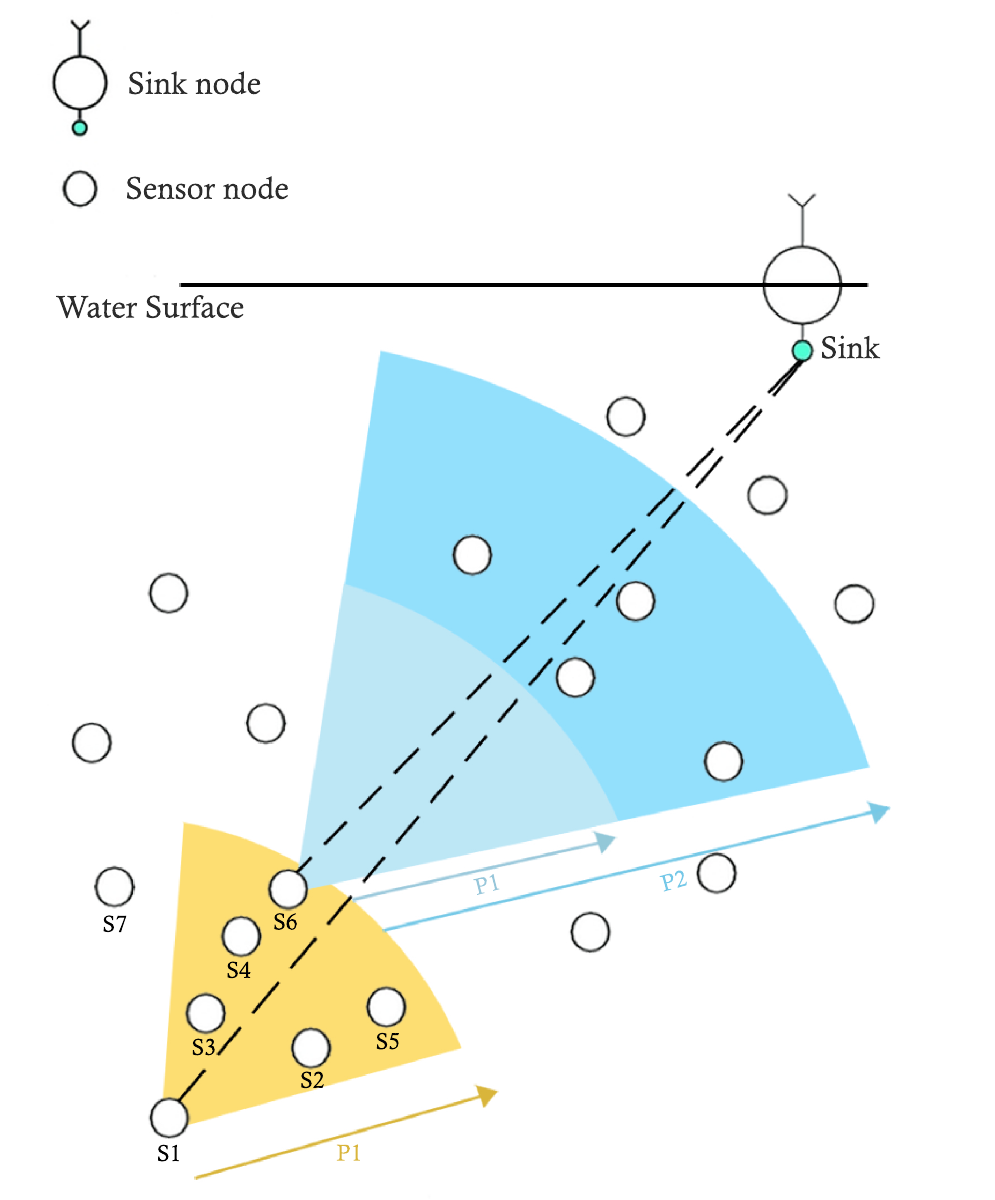
Figure 5. Representation of the routing process based on the proposed EE-UWSNs